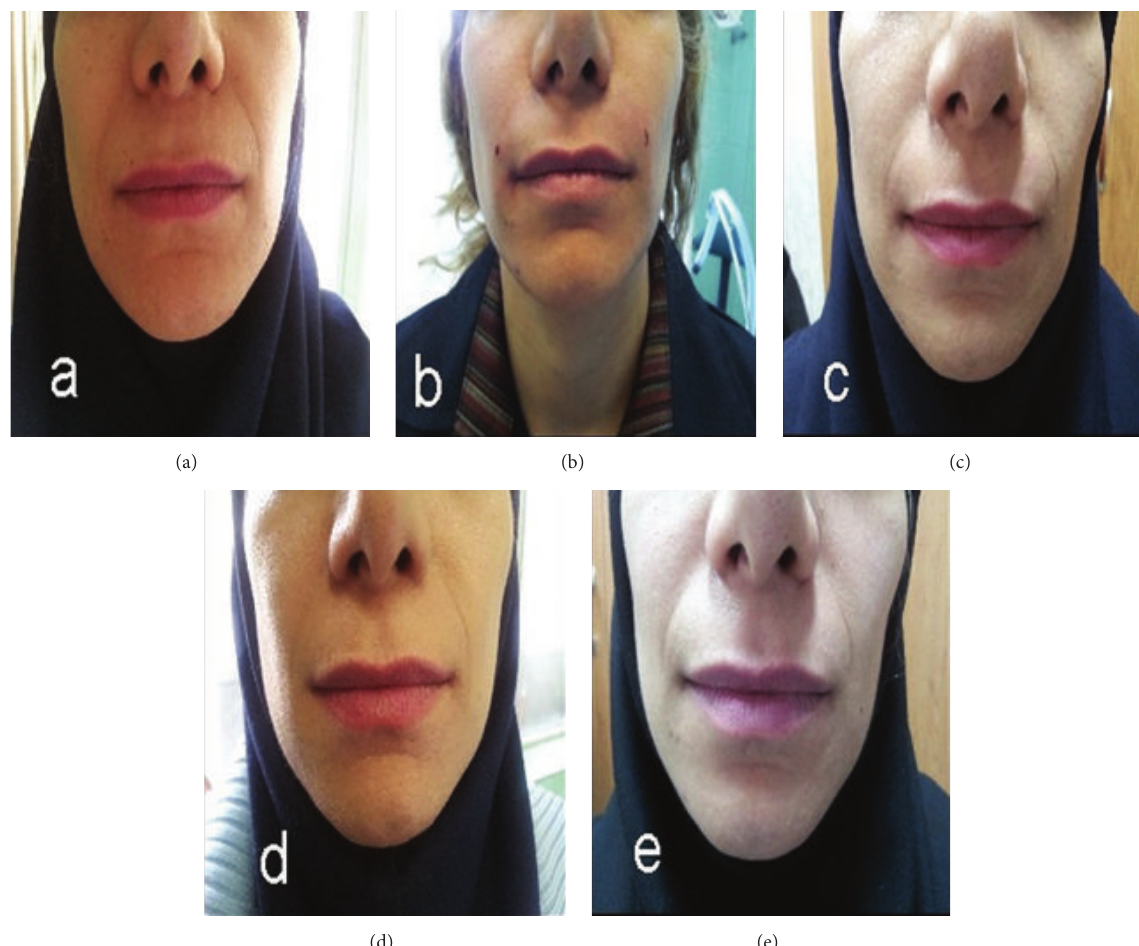
Figure 2: The considerable improvement of nasolabial folds after subcision; (a) before and (b) immediately after treatment ( > 75% improvement), (c) one month (50–75% improvement) and (d) three months after subcision (25–50% improvement), and (e) six months after treatment ( ≈ 25% improvement especially in upper portion of NLFs). No depression at the needle insertion points was